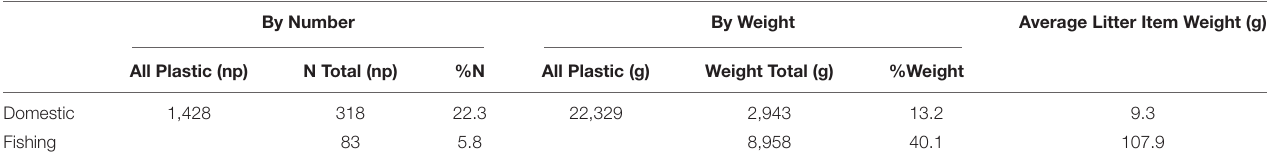
TABLE 3 | Analysis of two categories of litter items, one consisting of litter items associated with the fishing industry and one of litter items associated with domestic waste and littering. By Number By Weight Average Litter Item Weight